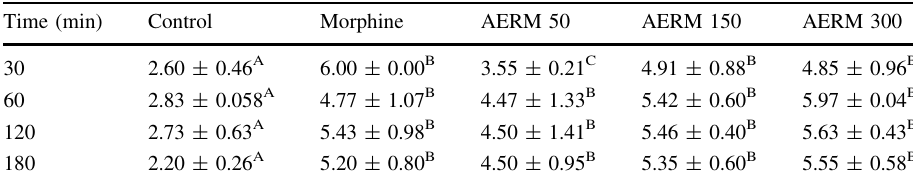
Table 4 Analgesic effect by tail-flick test of AERM (50, 150 and 300 l g kg - 1 )